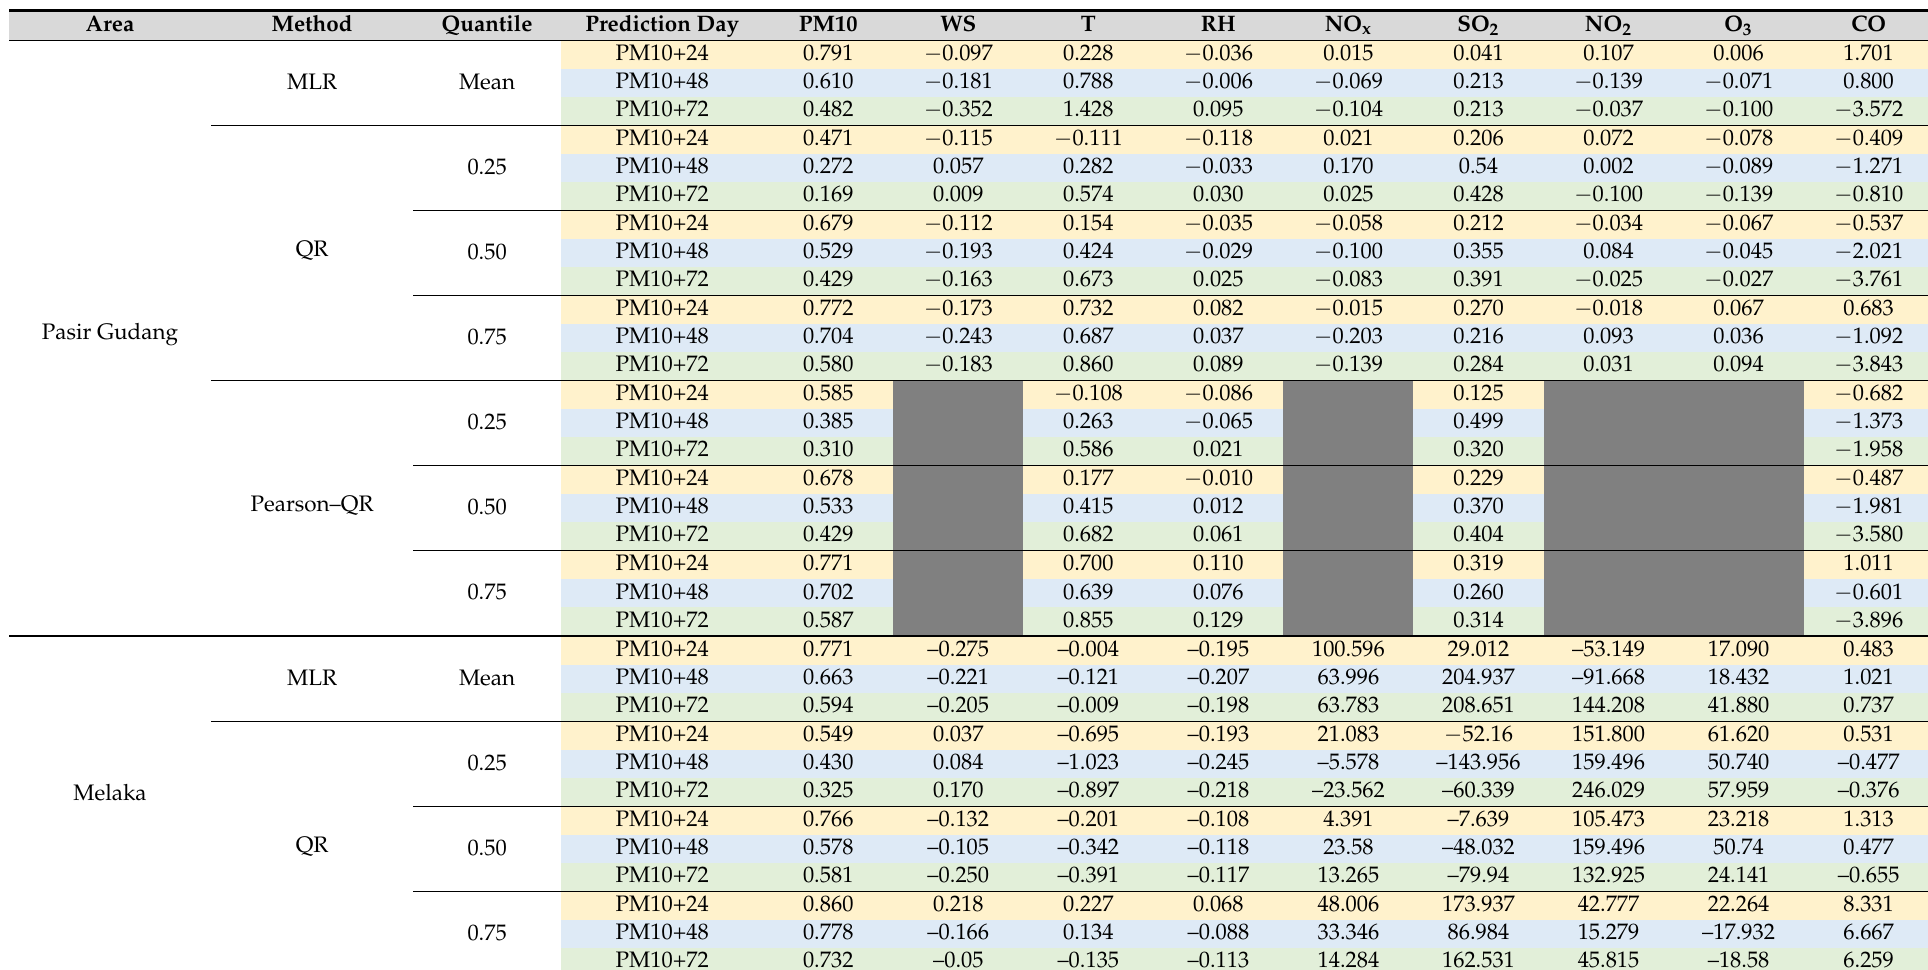
Table 7. MLR, QR, and modified QR (Pearson–QR) equations for PM10 level prediction. The cream color represents the next-day prediction (PM10+24);